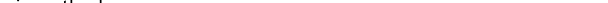
Algorithm 1. Algorithm of the synthesis